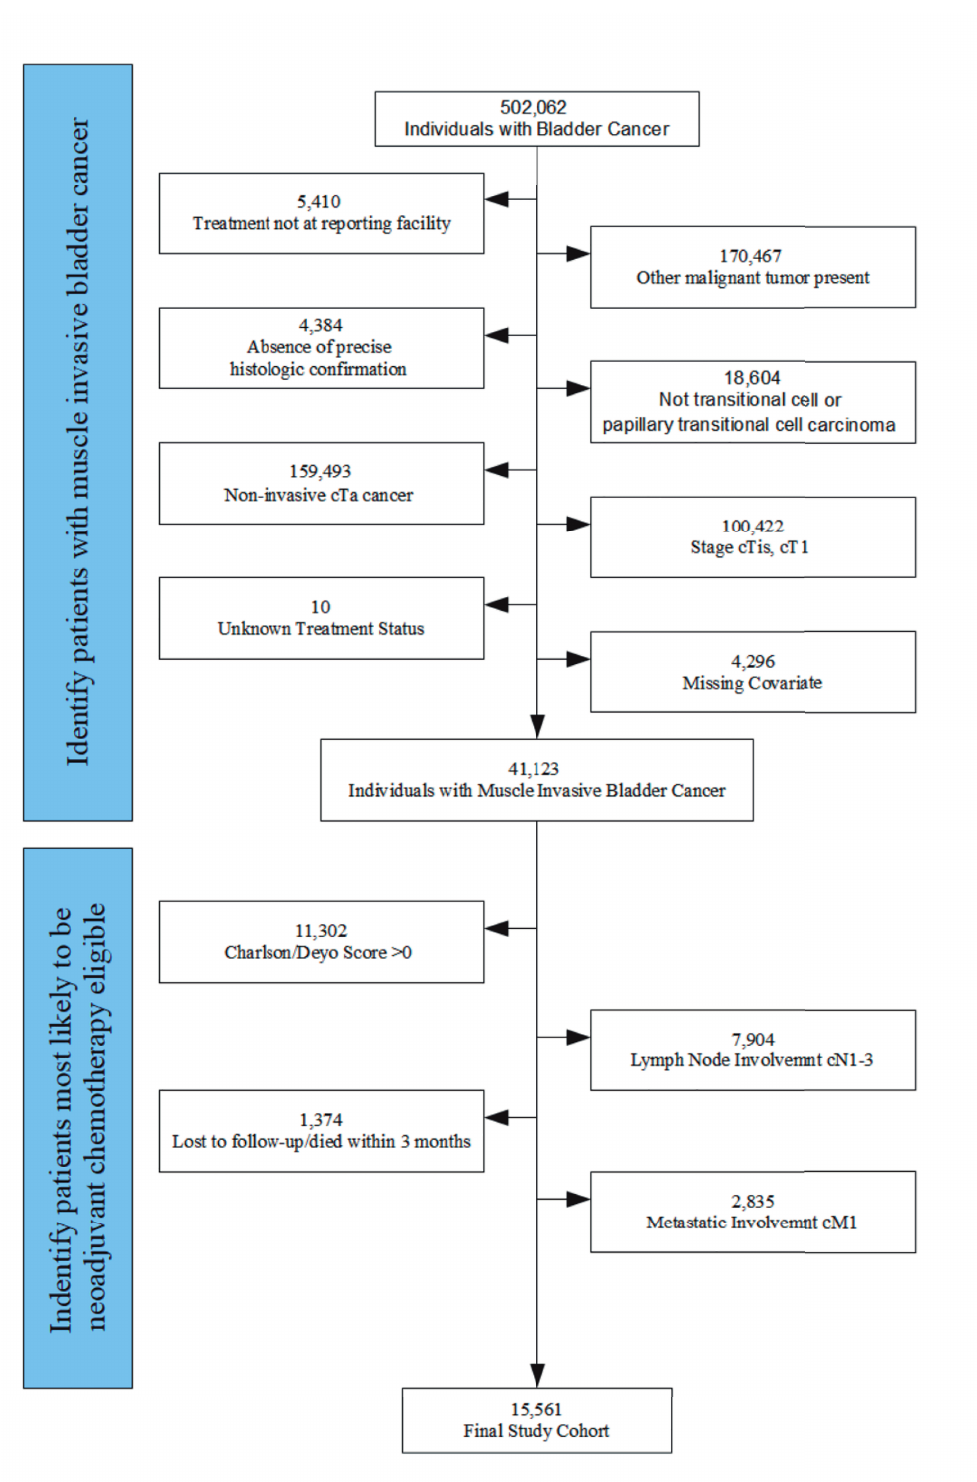
Figure 1 - Cohort generation from U.S. National Cancer Database